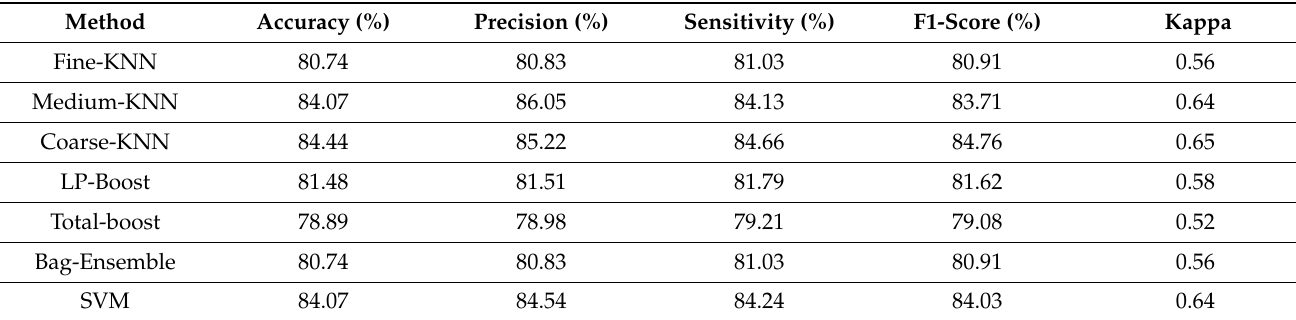
Table 7. Results obtained using different ML classifiers on 60–40